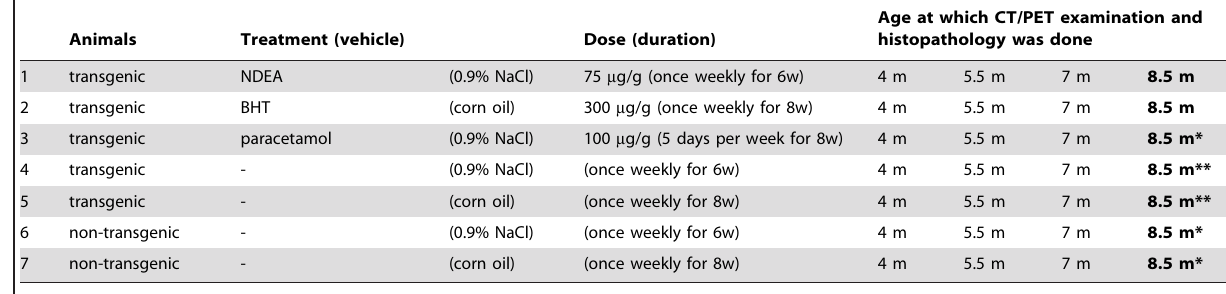
Table 1. Study groups and imaging